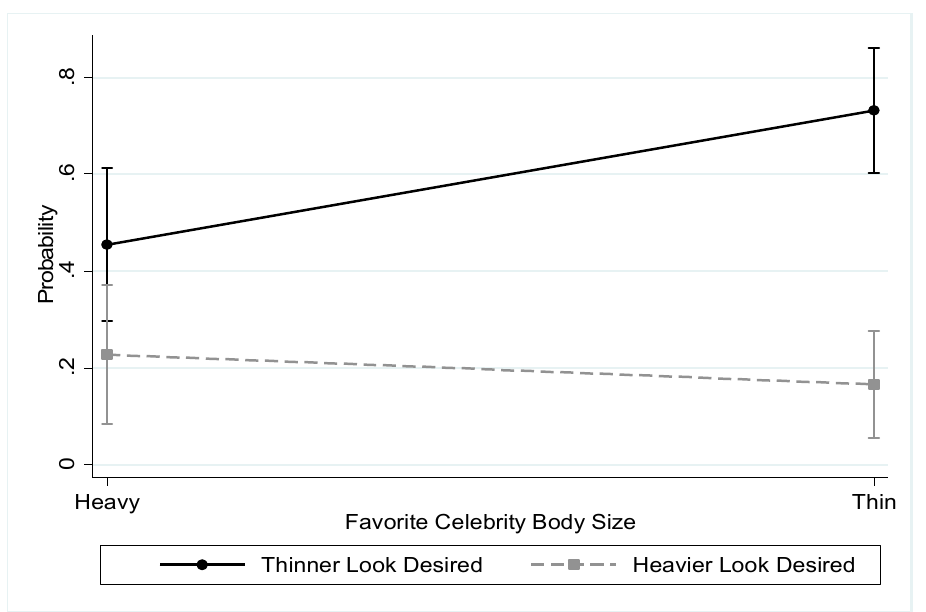
Figure 1. Predictive Margins for Thin Celebrities Treatment and Favorite Celebrity Body Size (Thin versus Heavy).